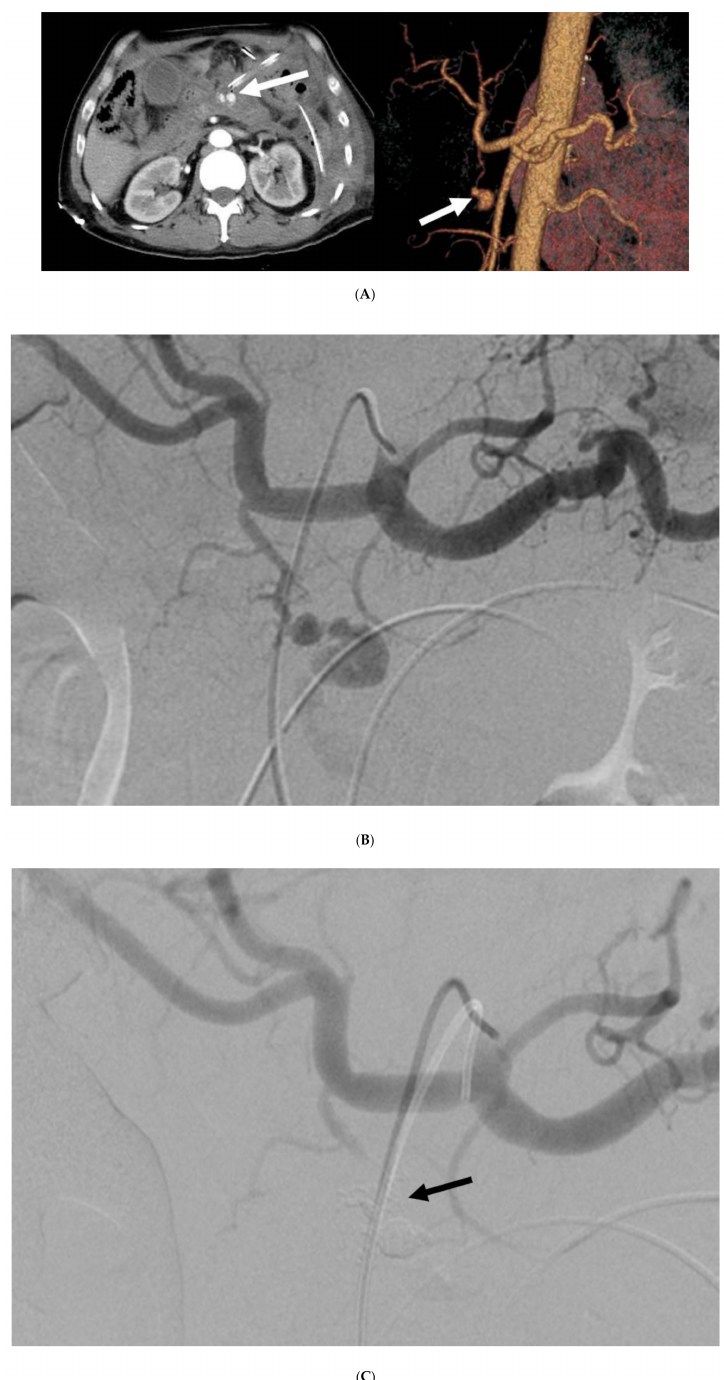
Figure 2. Transcatheter arterial embolization with N-butyl cyanoacrylate. Angiographic images of a 73-year-old man who underwent distal pancreatectomy for pancreatic body cancer. Bloody fluid was detected in the drainage tube 13 days after surgery, and contrast-enhanced computed tomography was performed. ( A ) A pseudoaneurysm (indicated by the arrows) was identified in the gastroduodenal artery by contrast-enhanced and three-dimensional CT (left and right images, respectively). ( B ) The celiac axis angiogram revealed a pseudoaneurysm in the gastroduodenal artery. A microcatheter could not be inserted into the distal site of bleeding, and so 0.6 mL of a 1:3 mixture of N-butyl cyanoacrylate / iodized oil was injected from the proximal site of hemorrhage. ( C ) Hemostasis was achieved after embolization with N-butyl cyanoacrylate (indicated by the arrow). There were no signs of recurrent bleeding or complications after transcatheter arterial